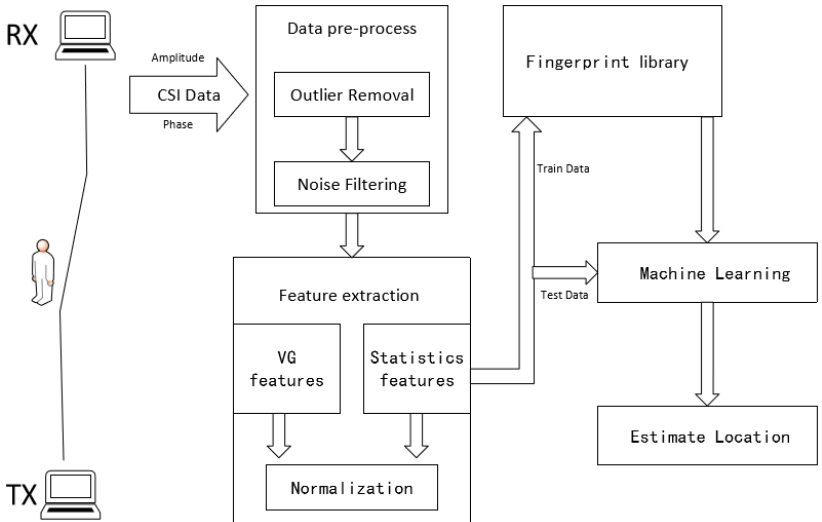
Figure 3. The system flowchart.